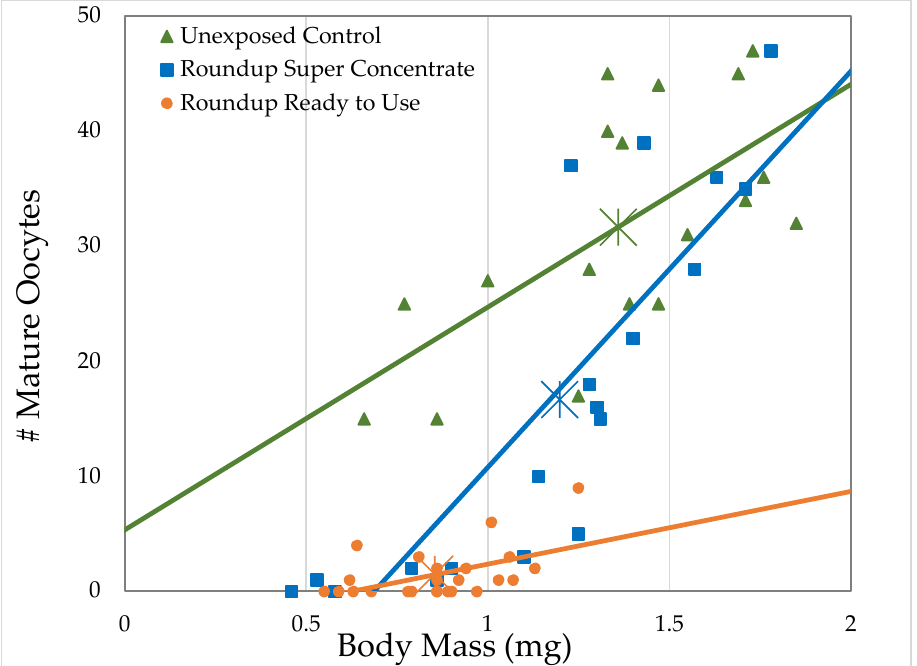
Figure 6. Relationship between the number of mature oocytes and body mass of D. melanogaster females exposed to herbicide at the highest concentrations used (4.64 mL/L Roundup ® Super Concentrate and 168.8 mL/L Roundup ® Ready to Use; each corresponds to 2 g/L glyphosate) within 2 h of eclosion for 7 days, compared to the ovary volume of females exposed to the control medium. Both Roundup ® formulations decreased the number of mature oocytes in female D.